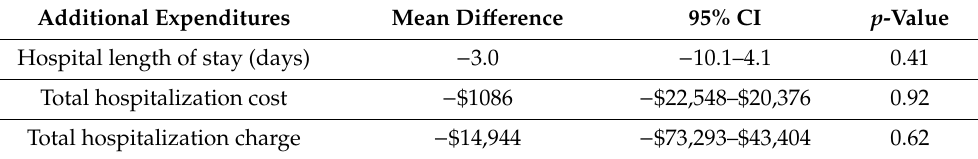
Table 3. Hospital length of stay and expenditure di ff erences between ADPKD and non-ADPKD patients with